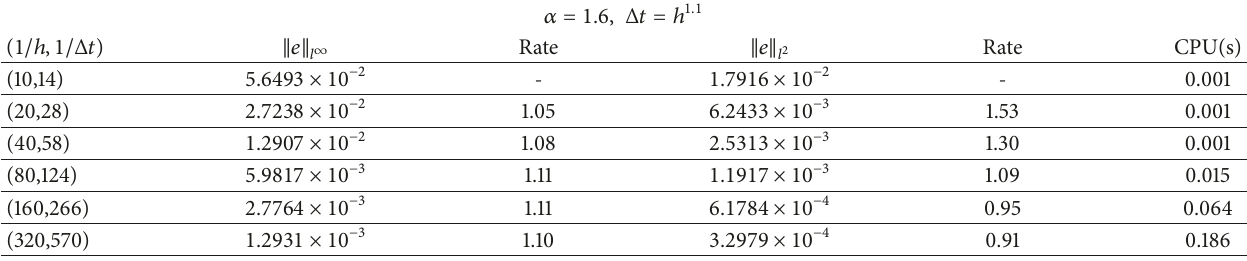
Table 9: Error and convergence rates for Example 1 by [19].